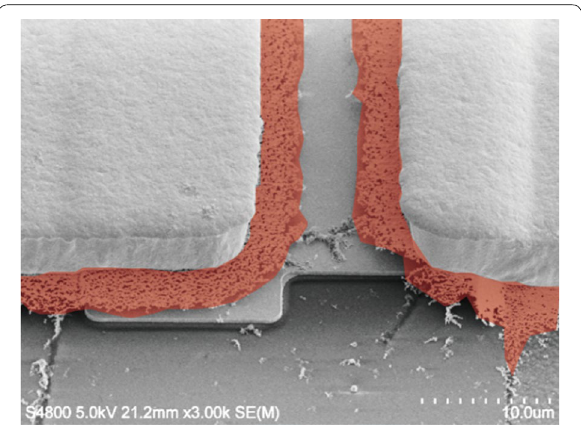
Fig. 5 SEM top‑view image of the fabricated Au–Au/CNT‑composite contacts RF‑MEMS switch. For clarity, the cantilever and burr are colored